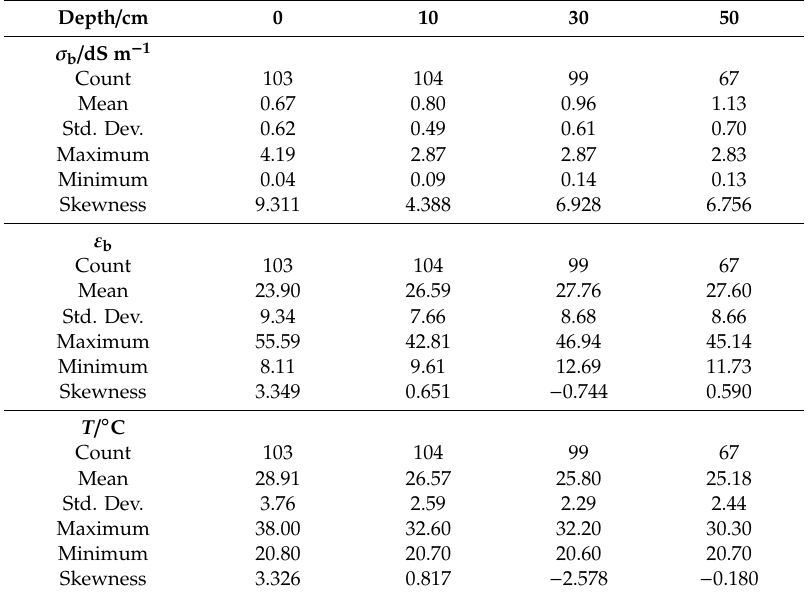
Table 4. Statistical summary of the soil bulk electrical conductivity ( σ b ), relative dielectric permittivity ( ε b ), and temperature ( T ) measurements taken in the study area with the WET-2 at different depths.